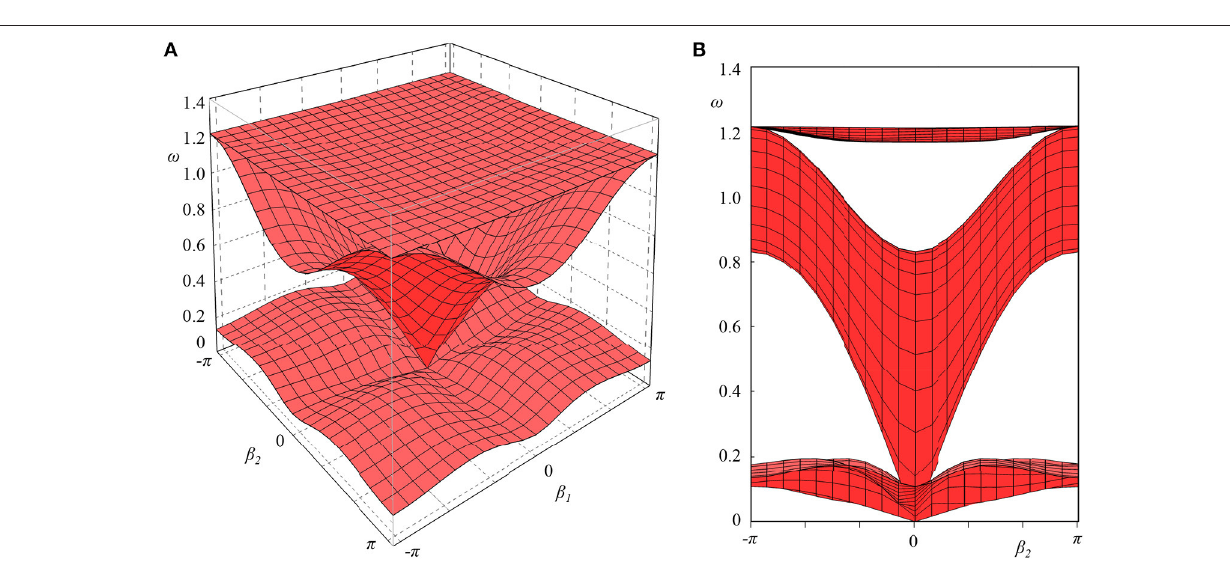
FIGURE 7 | Dispersion spectrum for the optimized beam lattice model of the tetrachiral material: (A) 3D view and (B) 2D